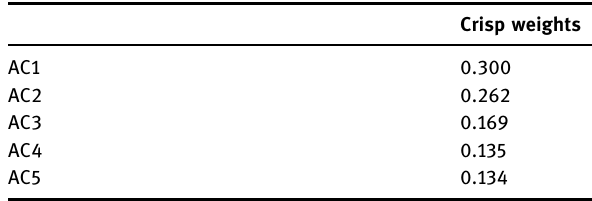
Table 9: SF_AHP crisp weights for indicators